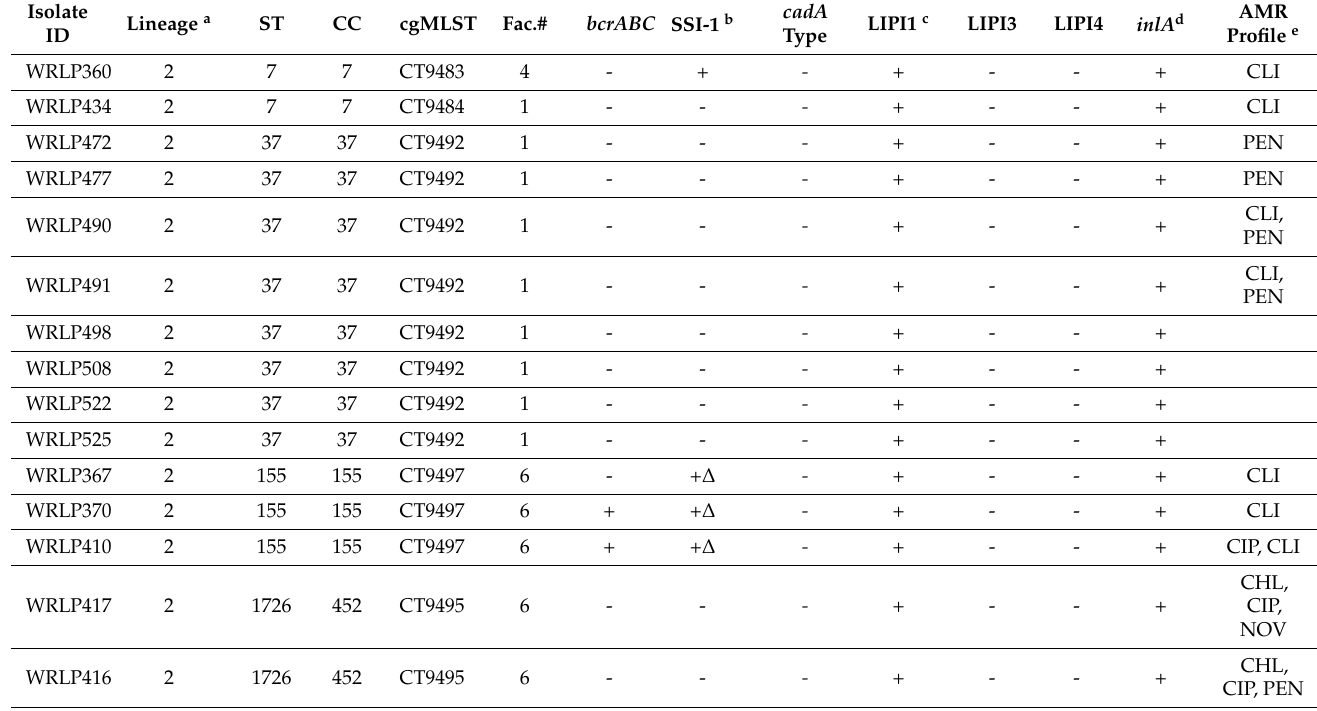
Table 1. Distribution of antimicrobial resistance genes and virulence factors across the isolates. Isolate Lineage ID